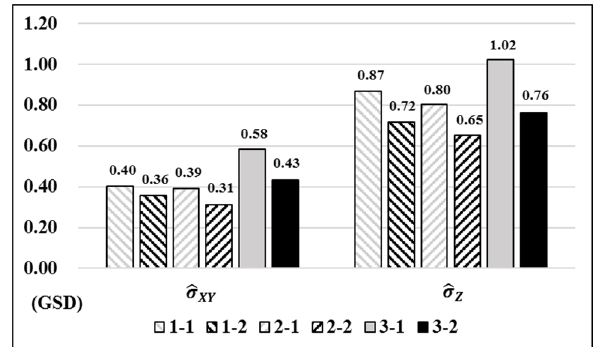
Figure 9. The RMS of (cid:2026)(cid:3548) (cid:3025)(cid:3026) , (cid:2026)(cid:3548) (cid:3027) of all ground points